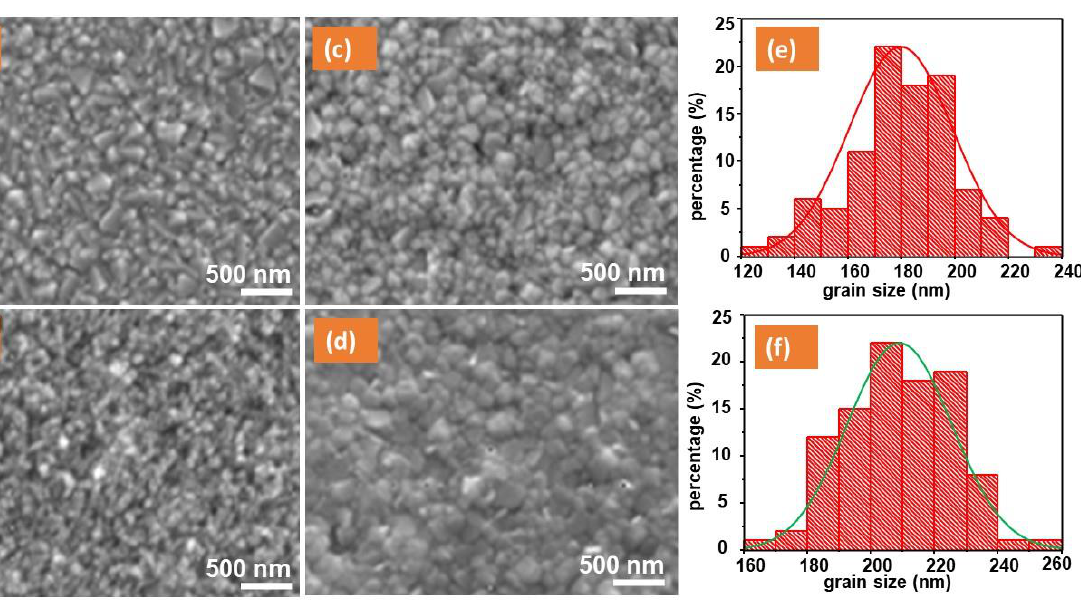
Figure 1. SEM images of: ( a ) bare FTO/glass; ( b ) FTO/c-TiO 2 /meso-TiO 2 ; ( c ) FTO/c-TiO 2 /meso- TiO 2 /perovskite; and ( d ) FTO/c-TiO 2 /meso-TiO 2 /Cdot/perovskite, Grain-size histograms on perov- skite surface of ( e ) FTO/c-TiO 2 /meso-TiO 2 /perovskite and ( f ) FTO/c-TiO 2 /meso-TiO 2 /Cdot/perov- skite.